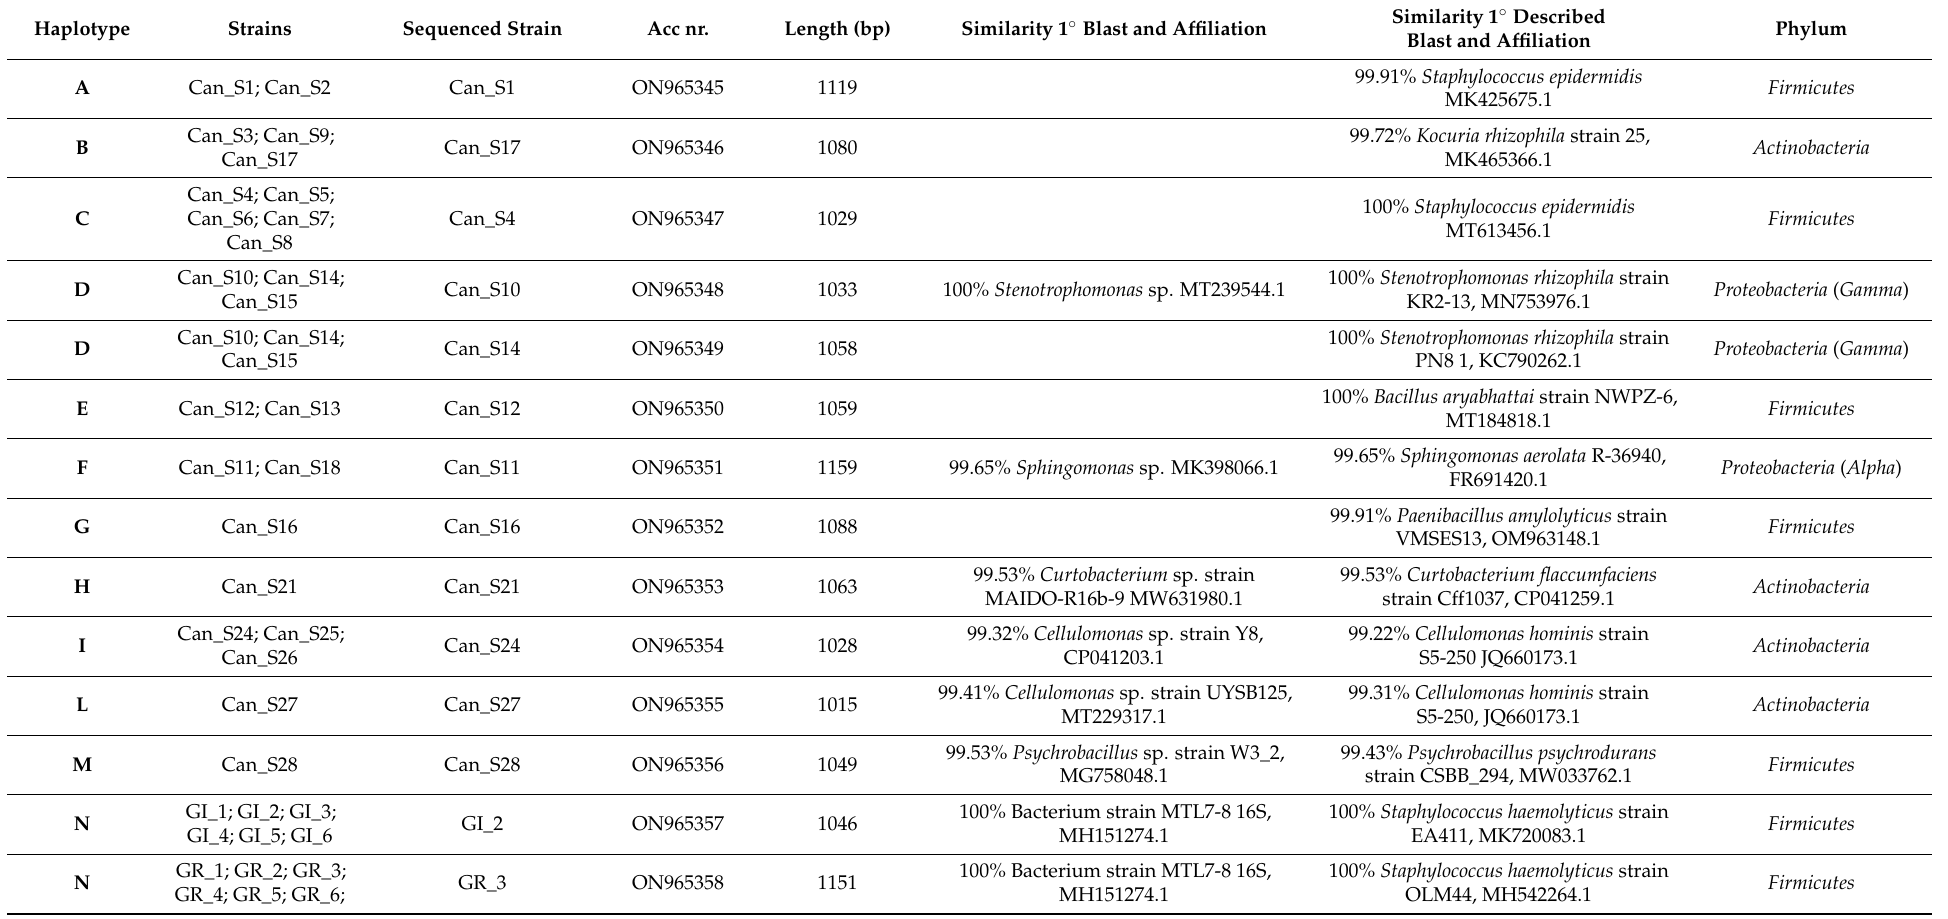
Table 1. Blast analysis results and ARDRA screening for the haplotype attribution of the isolated bacterial